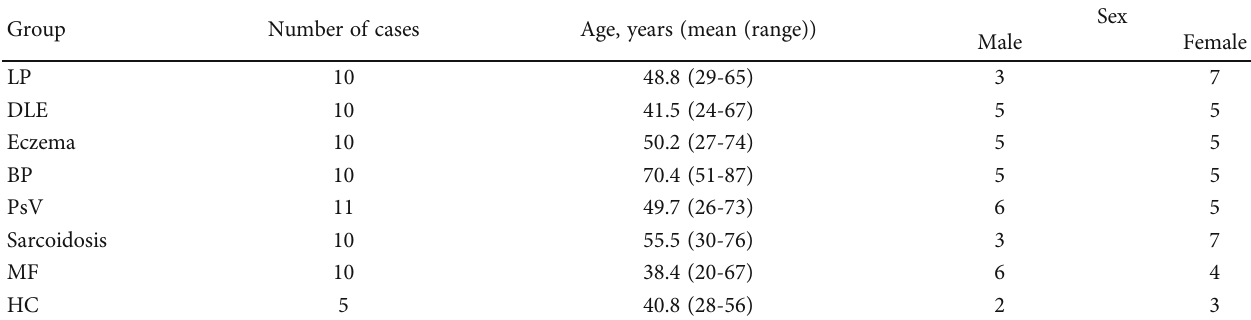
Table 2: List of participants for specimens used in a retrospective analysis.